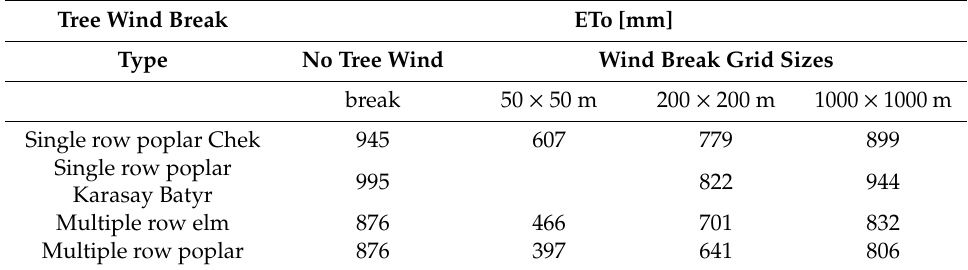
Table 5. ETo [mm] of open field conditions and under impact of di ff erent wind break types and grid